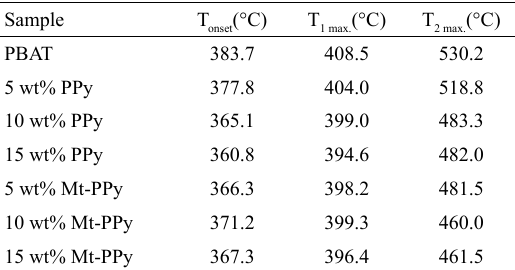
) and maximum onset) and T ) of neat PBAT and PBAT/ 1max. 2 max.